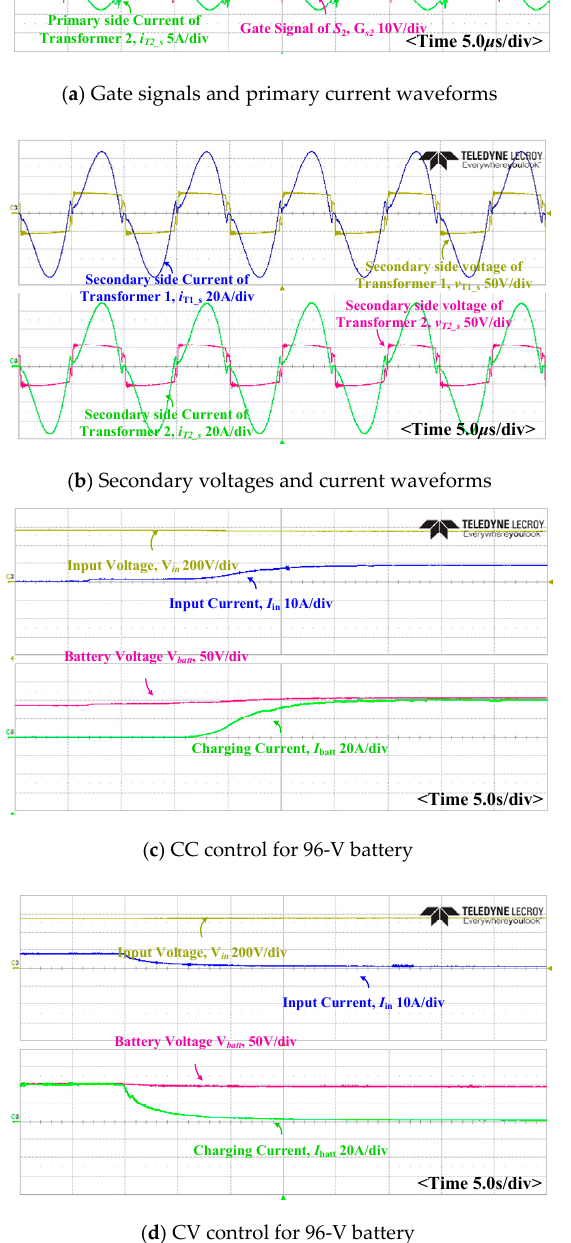
Figure 21. Experimental results of Switching Pattern 5.